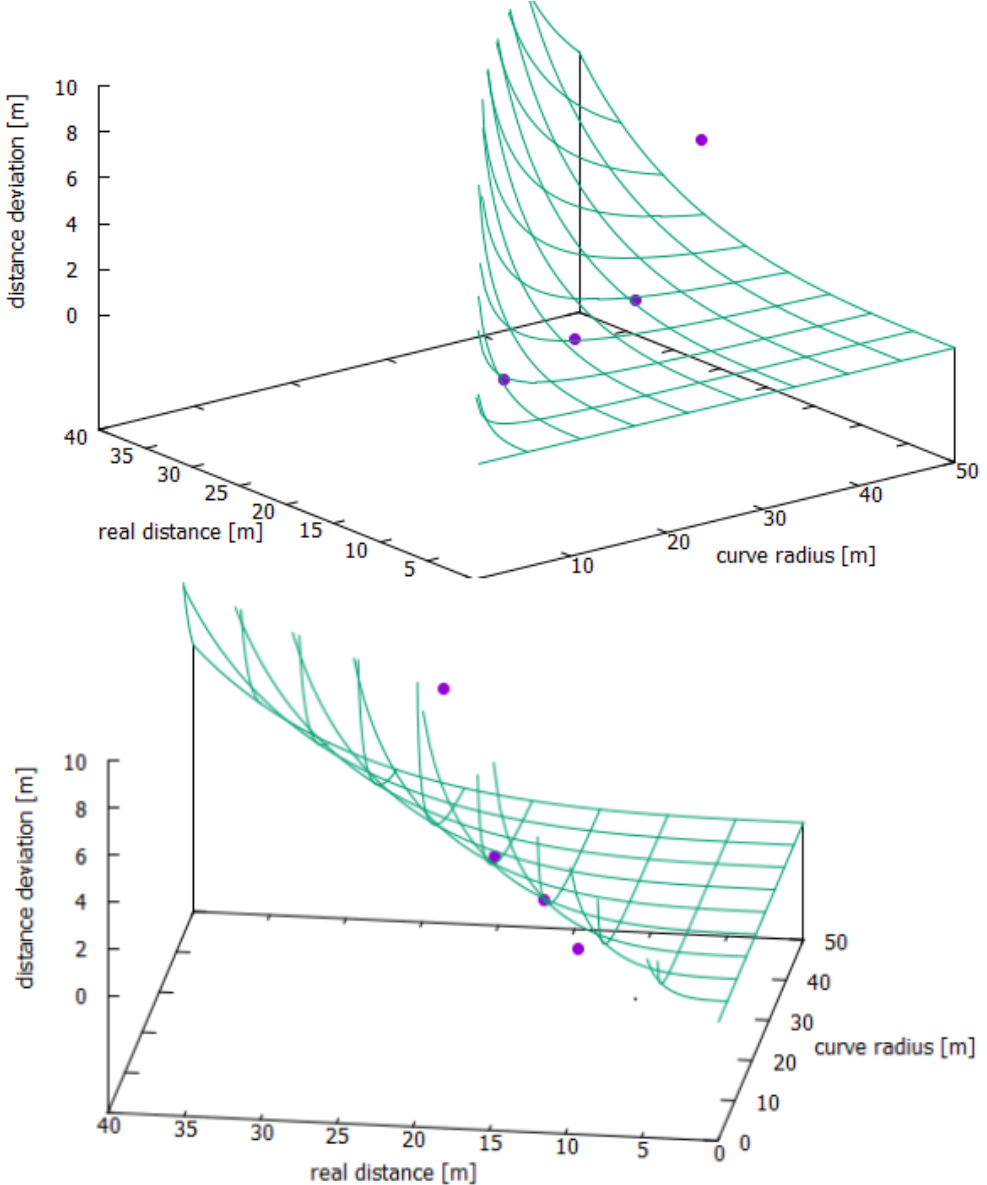
Figure 4. Average values of the measurements (purple dots) embedded in the theory error curve (green